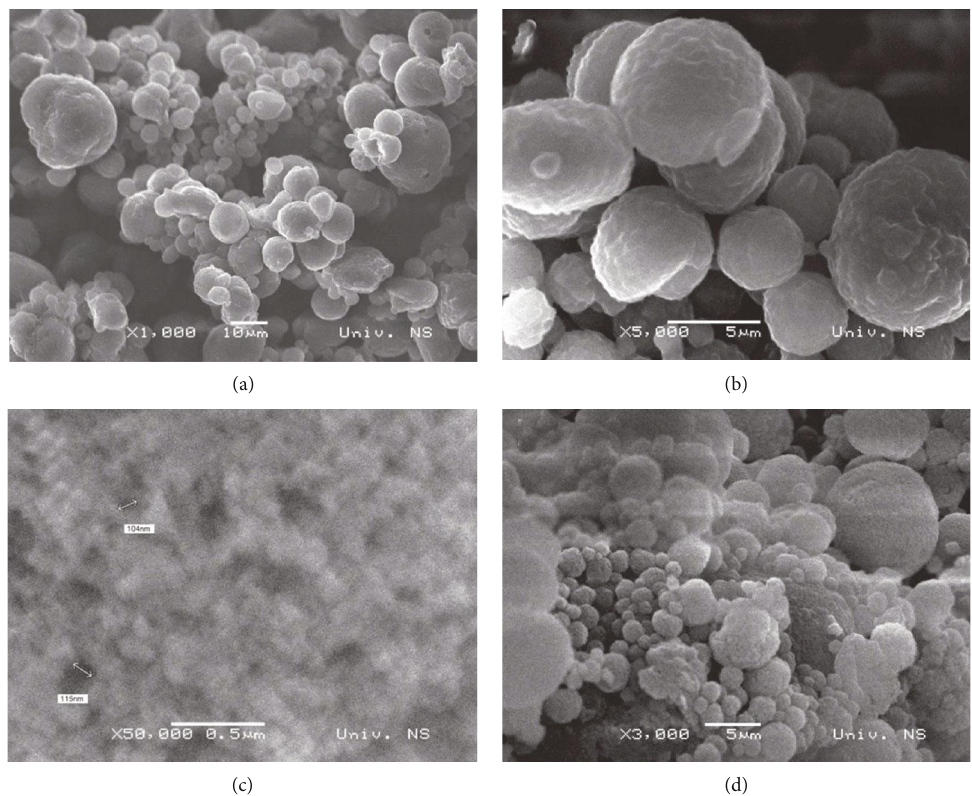
Figure 33: SEM micrographs of microcapsules obtained by cross-linking of gelatin: NaCAS coacervate for a mass ratio of 2 :1, with 0.2mmol of genipin/g of proteins. Magni fi cation of 1,000 × (a); 5,000 × (b); 50,000 × (c). Microcapsules after active compounds release (3,000 × ) (d) [110].